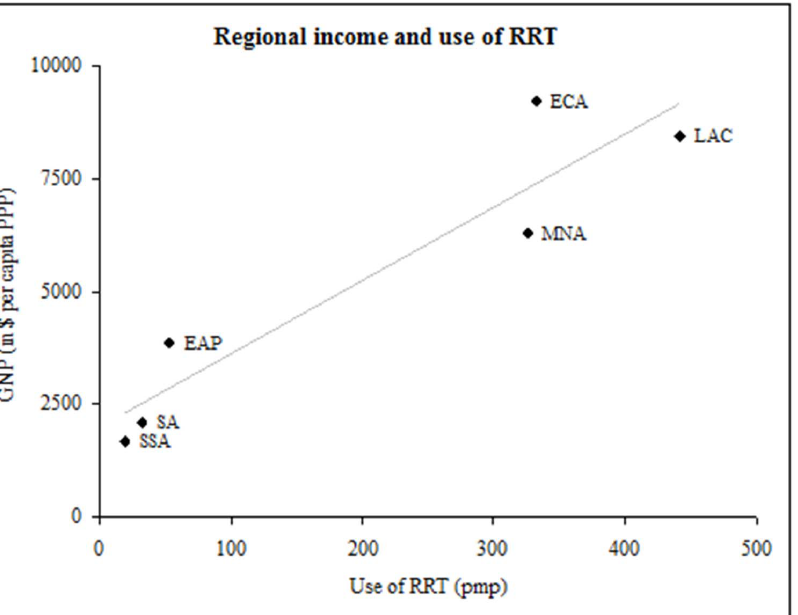
Figure 2. Regional income and use of RRT. Correlation between income and use of RRT in World Bank Regions (Pearson’s r =0.94). Income is reported as GNP in U.S. dollars per capita PPP from 2005. Abbreviations: RRT-renal replacement therapy, GNP-gross national income, PPP-purchasing power parity, ECA-Eastern Europe and Central Asia, LAC-Latin America and Caribbean, MNA-Middle East and North Africa, EAP-East Asia and Pacific, SA-South Asia and SSA-Sub-Saharan Africa.